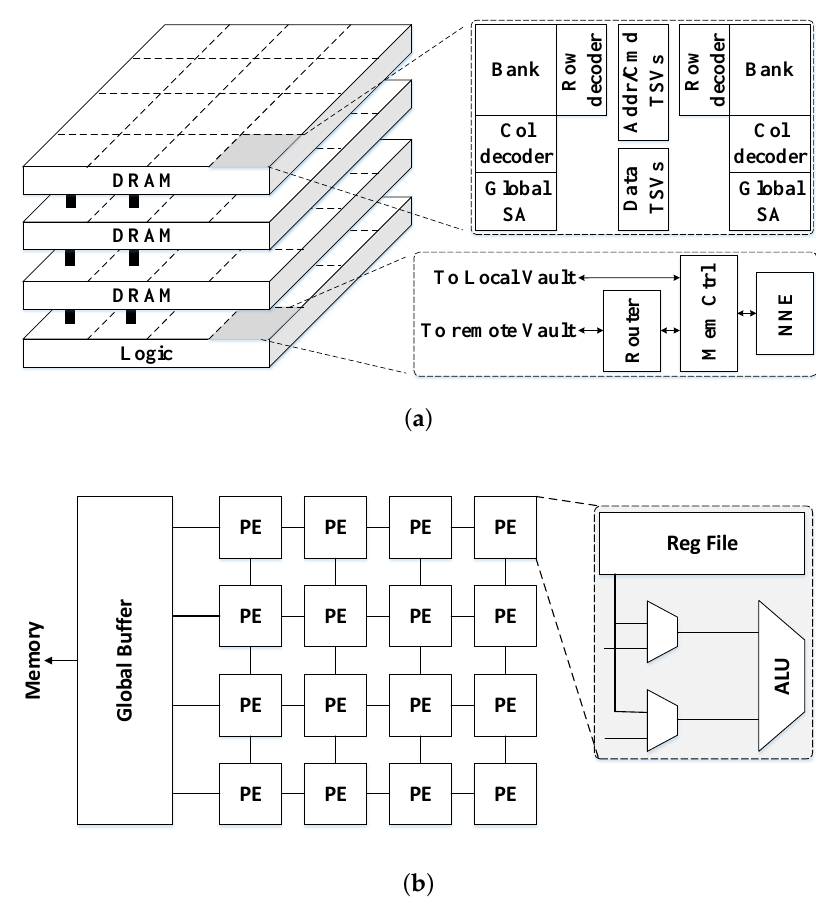
Figure 17. ( a ) Overview of the TETRIS architecture and ( b ) organization of a Neural Network Engine (NNE) (adapted from